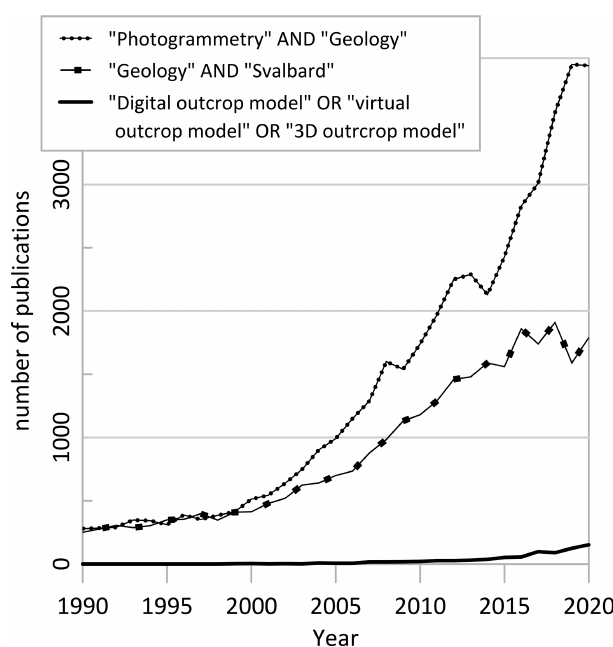
Figure 1. The digital geology revolution, as illustrated by the expo- nential growth in publications from 1990 to 2020 that include “pho- togrammetry” and “geology”. Similarly, a marked increase is seen in publications including “geology” and “Svalbard”. Data source: Google